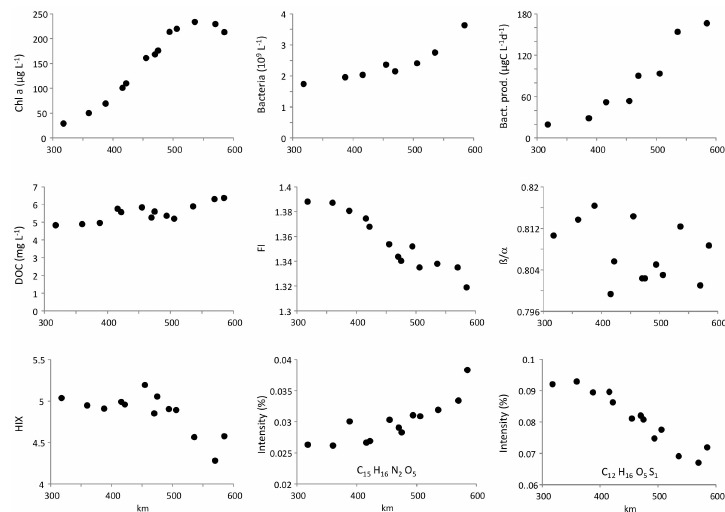
Figure 1. Lateral averages of averages of chlorophyll a, bacterial abundance bacterial production, concentration of dissolved organic carbon (DOC), fluorescence index (FI), freshness index ( β / α ),humification index (HIX), and two examples for molecular formulas with decreasing and increasing relative intensities along the river Elbe between river kilometers